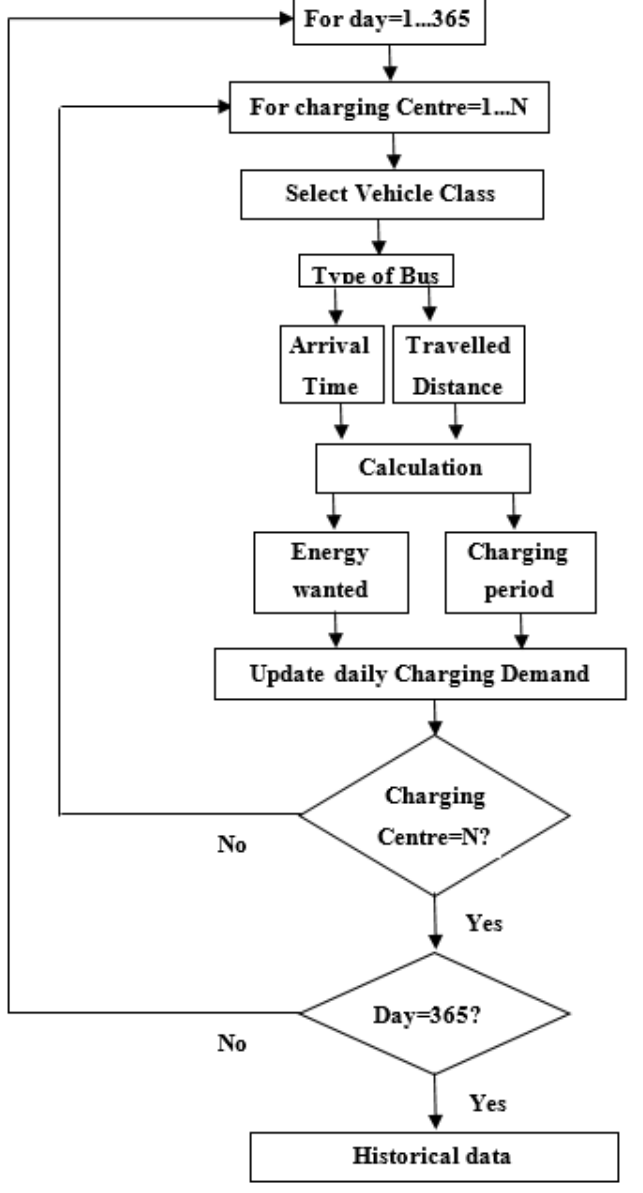
Figure 3. Flowchart of charging dataset generation for e-buses.